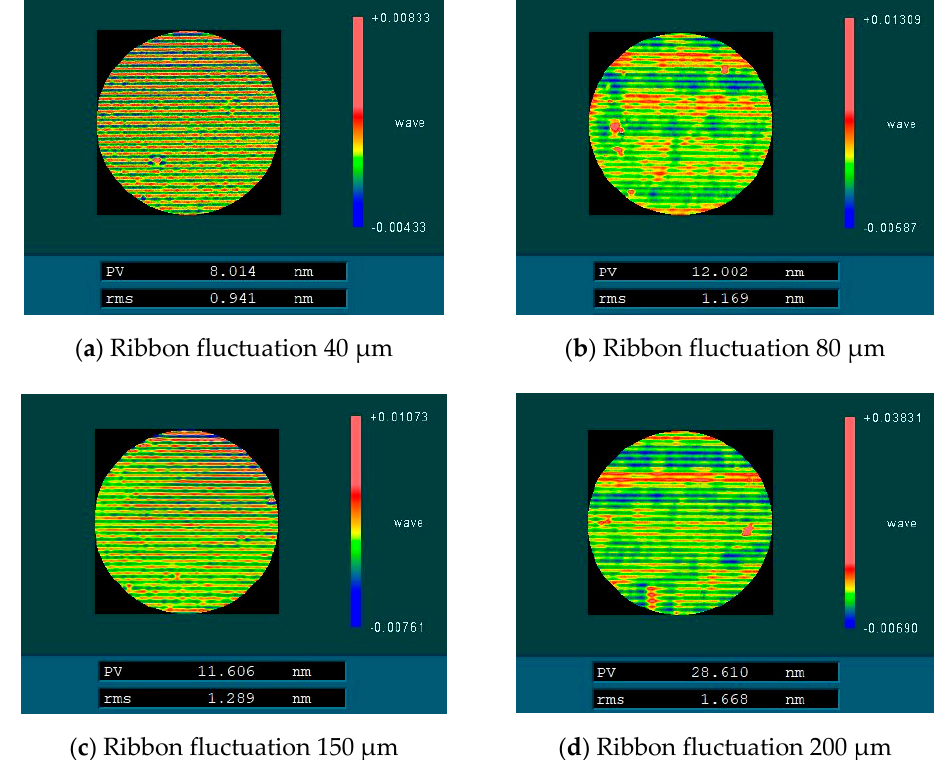
Figure 18. Effects of different ribbon fluctuations on the full frequency RMS of PSD2.